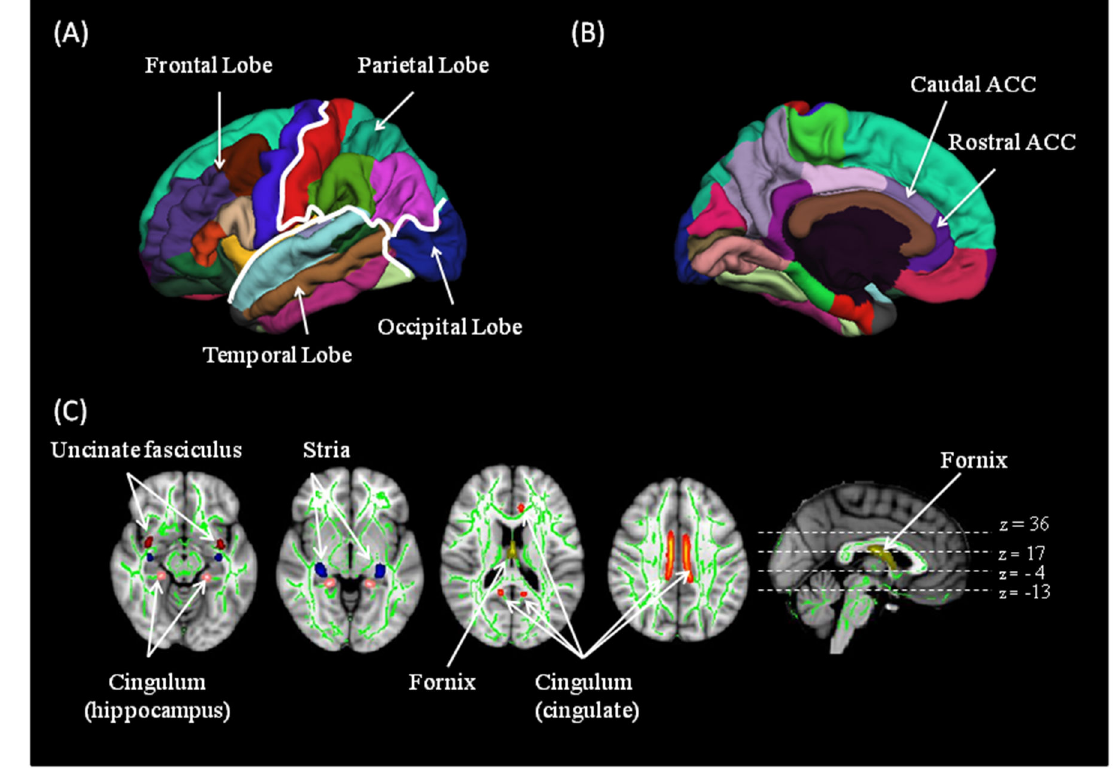
Figure 1. Grey matter and white matter regions of interest used in the study. (top row) Different brain lobes (A) and the rostral and caudal anterior cingulate sub-regions (B) parcelled using freesurfer for a representative dataset (bottom row (C)). Fractional anisotropy skeleton (in green) representing the major white matter tracts for all subjects is overlaid on the MNI standard brain. Sections of the tract sekeleton representing the cingulate and limbic white matter tracts are shown: cingulum cingulate bundle (orange); cingulum hippocampus bundle (pink); fornix (yellow); stria (blue) and uncinate fasciculus (red). Abbreviations: ACC, anterior cingulate